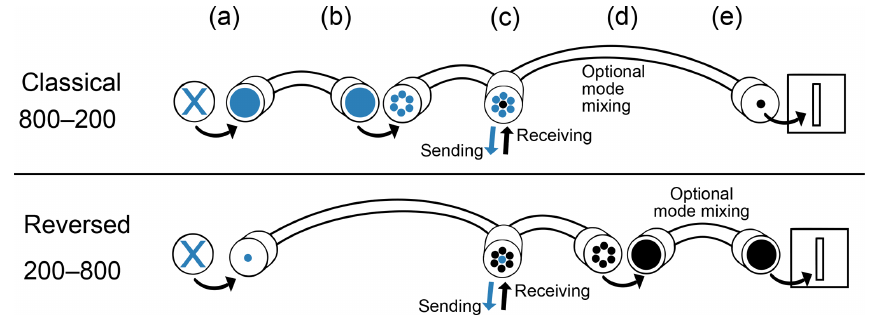
Figure 2. Schematic diagrams of sections of the fibre setup and corresponding cross sections when a Y-shaped bundle is used in the classical (top row) or reversed (bottom row) way. Additional fibres or fibre bundles can be coupled to the end of the receiving fibre section to improve mode mixing or change the cross section (not sketched). The letters A through E correspond to positions marked in Fig. 1.